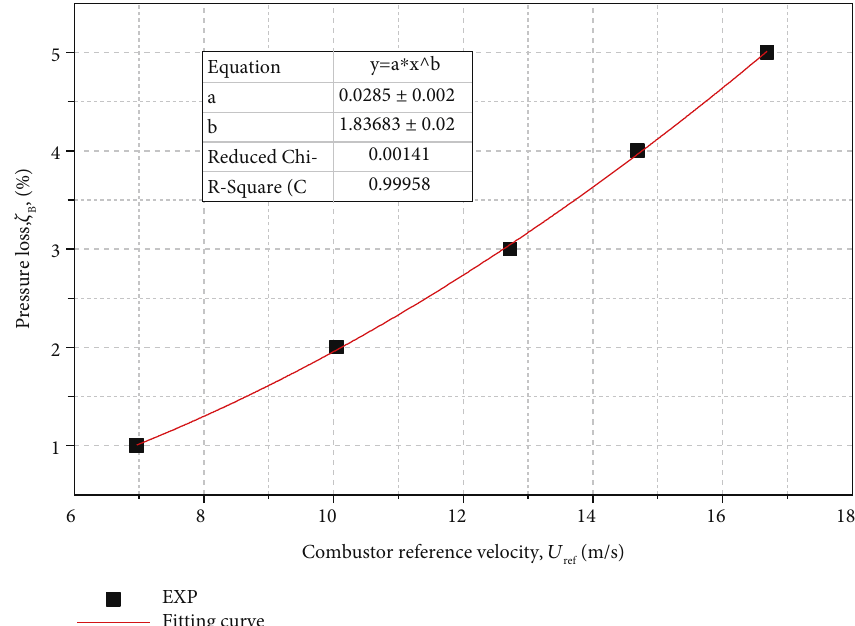
Figure 4: E ff ect of combustor reference velocity on total pressure